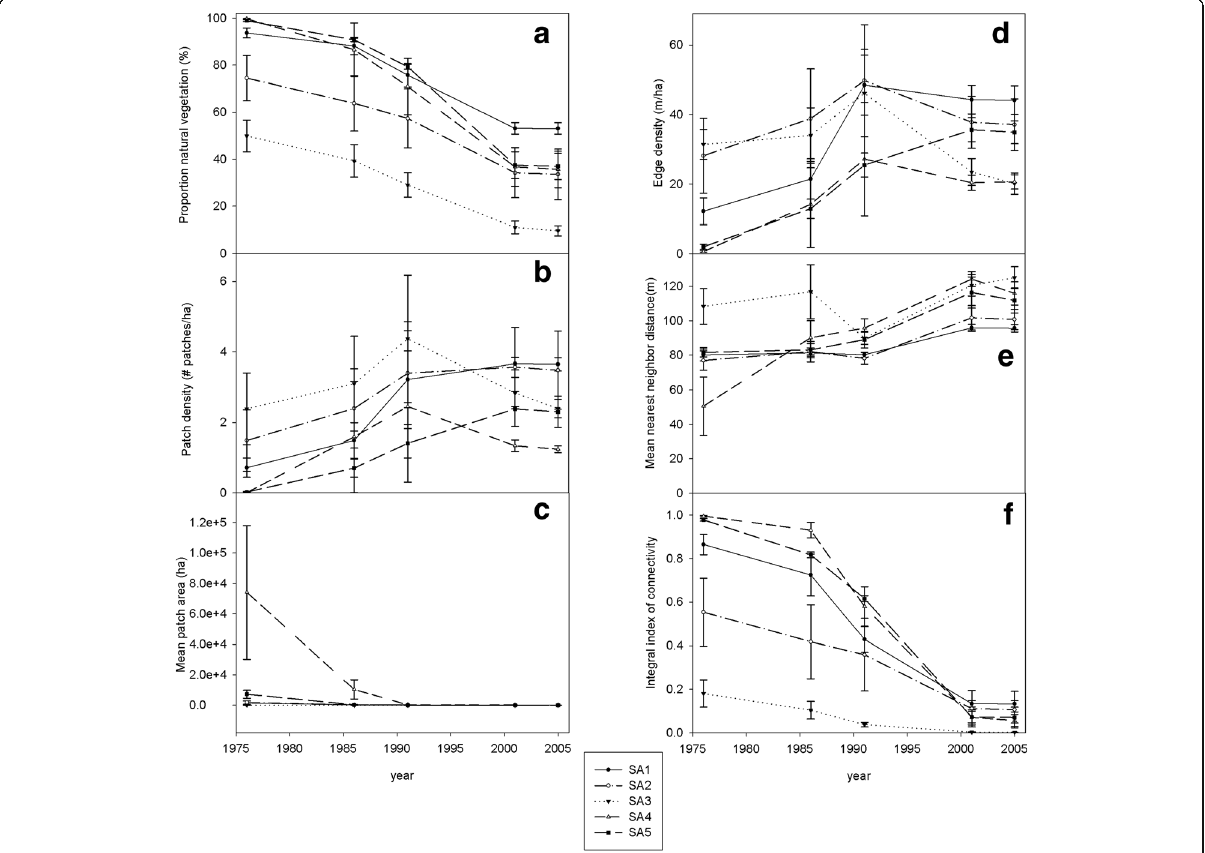
Fig. 2 Landscape metrics describing fragmentation and connectivity in five deforestation patterns in the lowland tropical forests in Bolivia: proportion of natural vegetation ( a ), patch density ( b ), mean patch area ( c ), edge density ( d ), mean nearest neighbour distance ( e ) and connectivity ( f ). The five deforestation patterns are the Chapare region (SA1), northwest colonization zone (SA2), the Santa Cruz integrated zone (SA3), the southern expansion zone (SA4) and the northern expansion zone